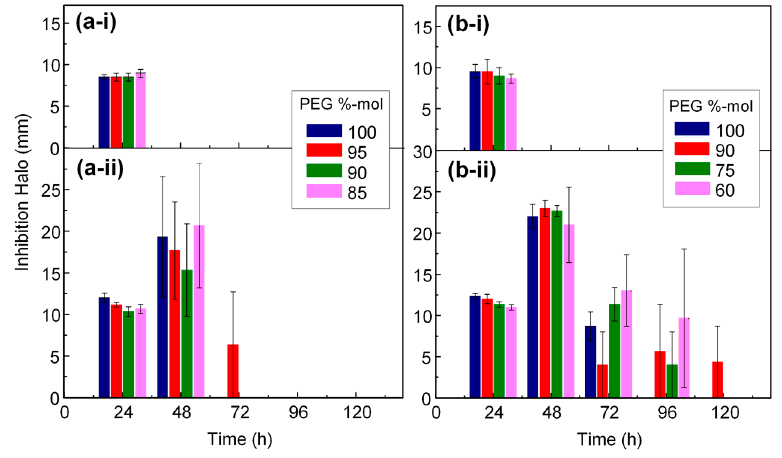
Figure 6. Graphical representation showing the antimicrobial efficacy of ( a ) Ag–PSA and ( b ) Ag–PU hydrogel nanocomposites: Inhibition halo distance (mm) over time against (i) E. coli and (ii) P . aeruginosa . Error bars represent standard deviation for studies conducted in triplicate.